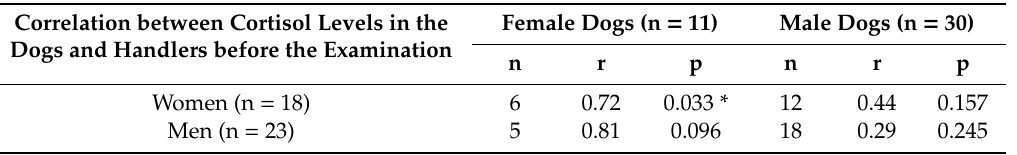
Table 4. Pearson’s linear correlation coefficient r between cortisol levels in the dogs and their handlers with reference to the sex of the handlers and dogs.